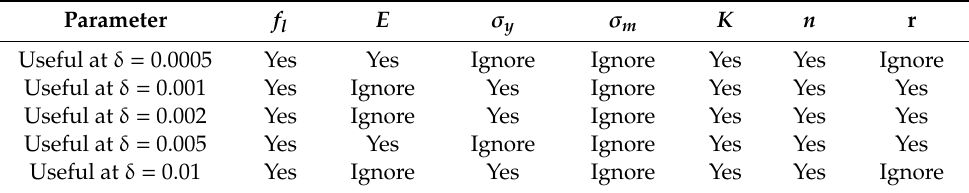
Table 2. The results of future selection analysis at δ = 0.0005 to